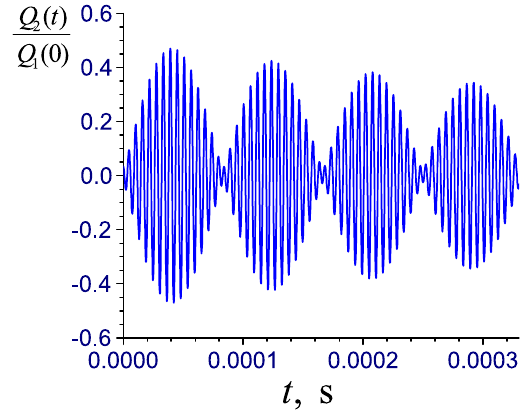
FIG. 11. Evolution of the charge Q 2 ð t Þ of the capacitor C 2 for the electronic circuit of Fig. 10 with no drive. The circuit parameters are given by Eqs. (E5) and (E6).